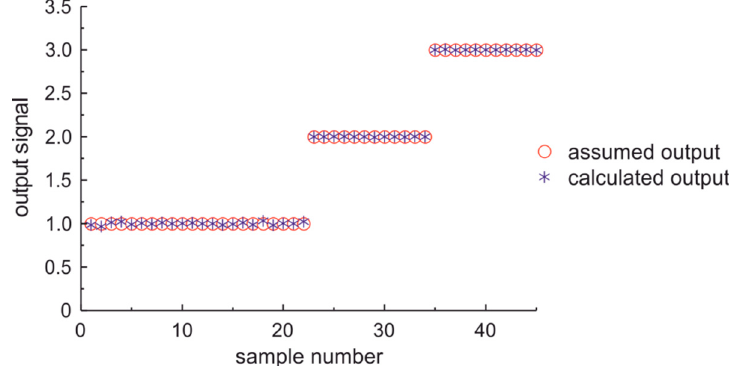
Figure 15. The assumed output values versus calculated output values of ANN classifier of fuel quality type.